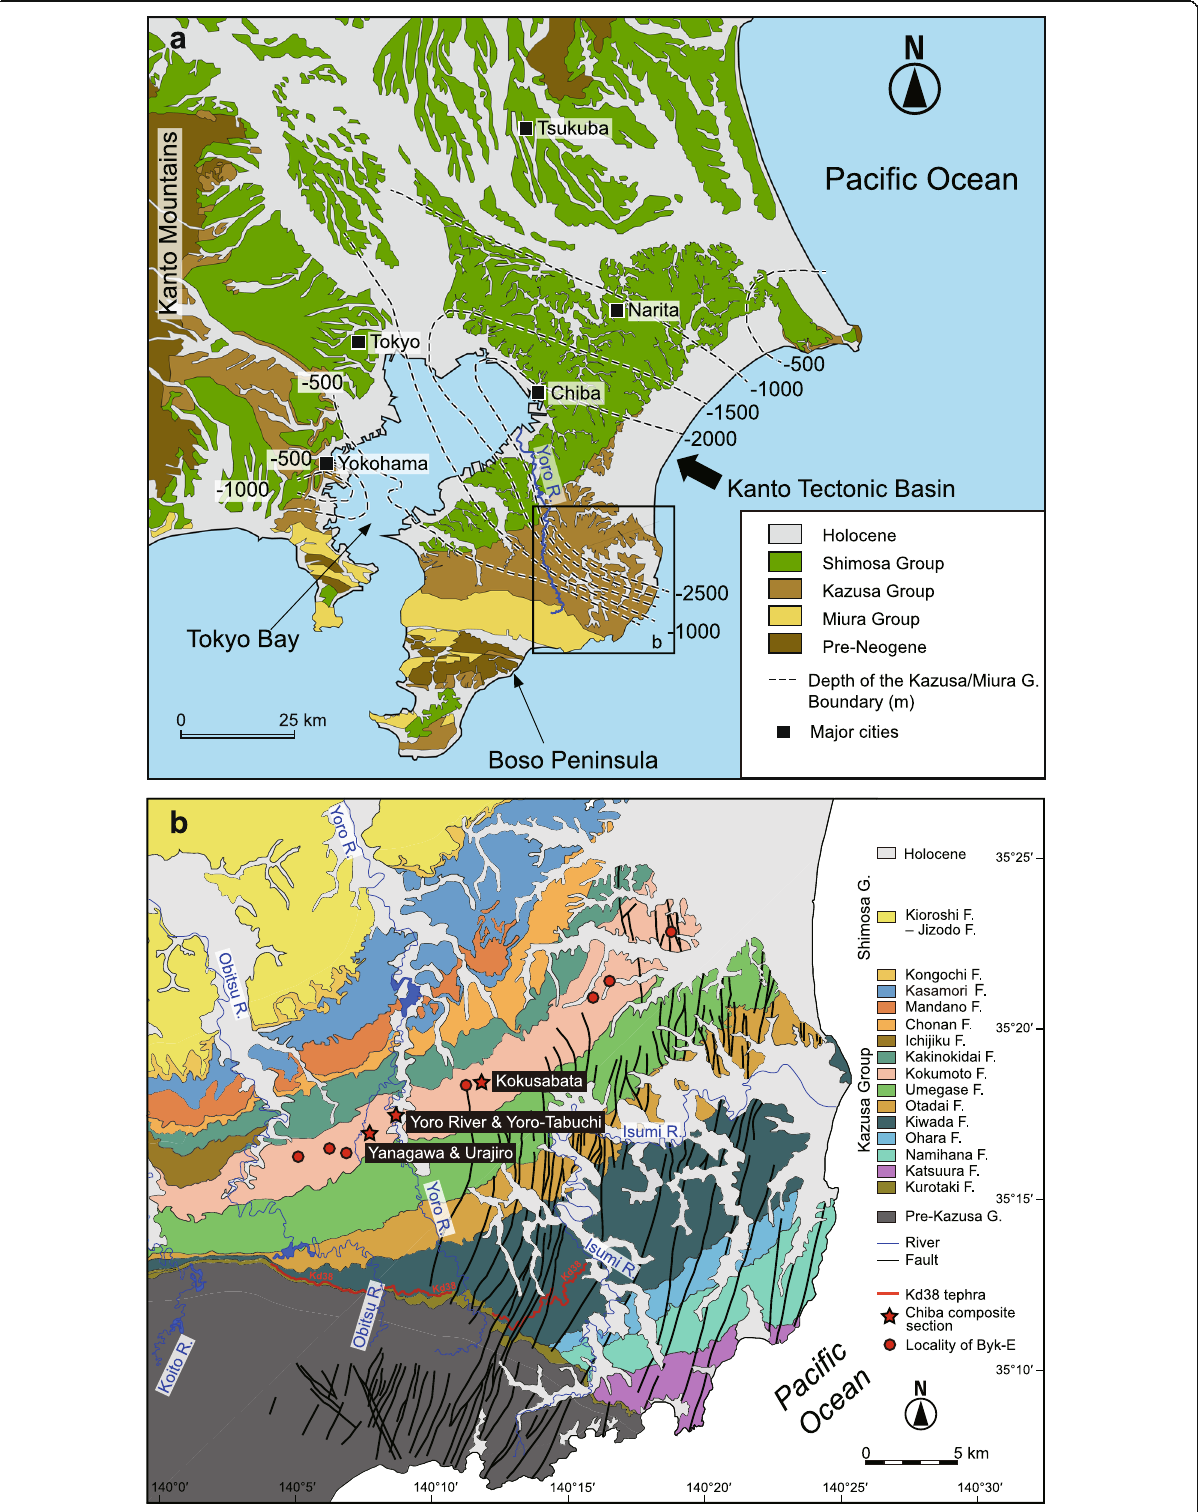
Fig. 2 a A simplified geological map of the entire Kanto area, which is redrawn after Kazaoka et al. (2015) and Suganuma et al. (2018). Box indicates location of a detailed geological map in b . b A detailed geological map of the Boso Peninsula, highlighting stratigraphy of the Kazusa Group and location of CbCS. Panel b is redrawn after Suganuma et al. (2018) and GSSP proposal group